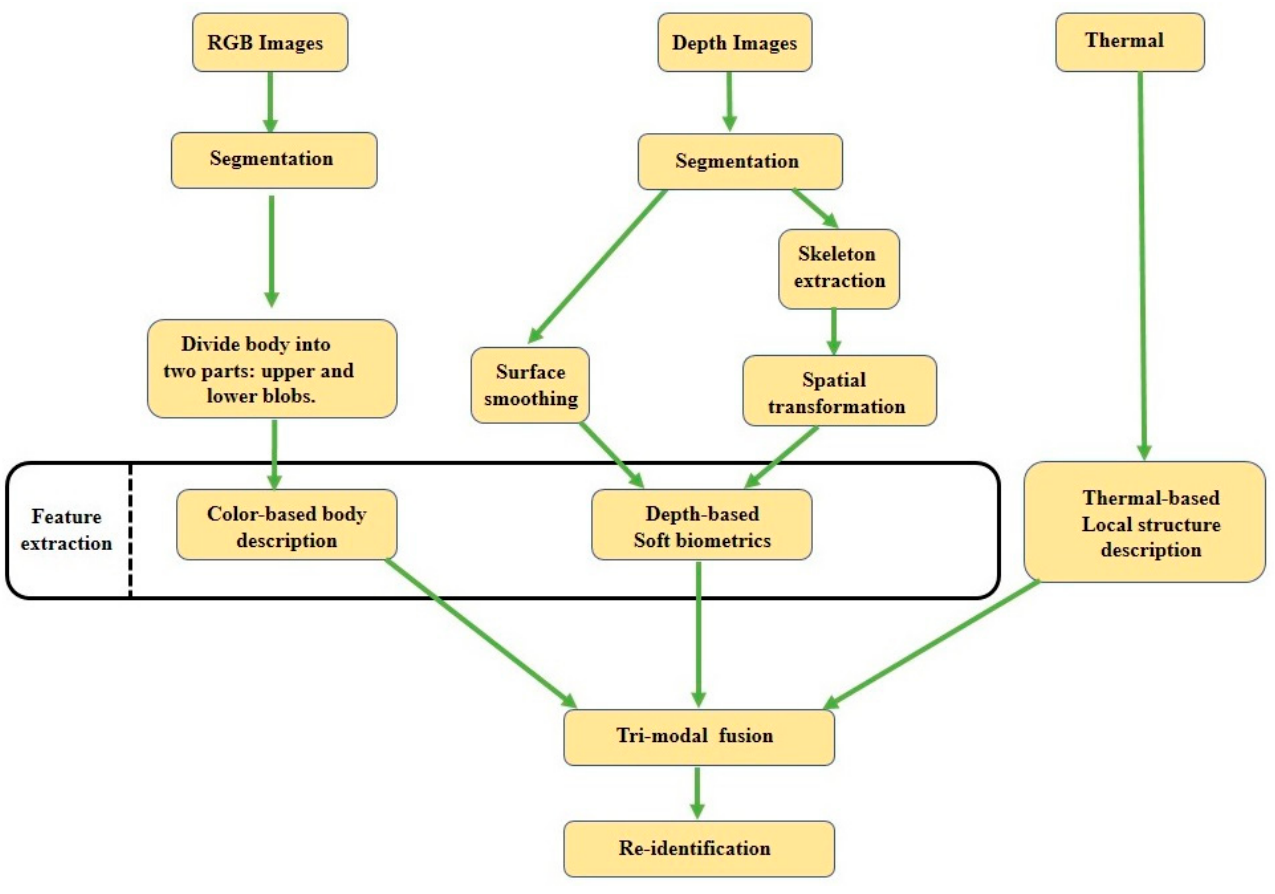
Figure 9. A flowchart of RGB–depth–skeleton-based Re-ID.